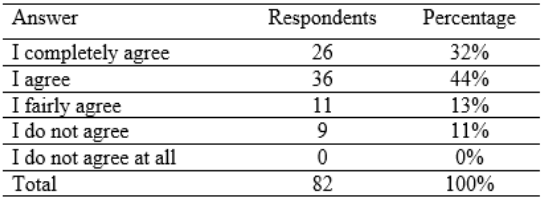
Table 5. Table of received answers to question number 15